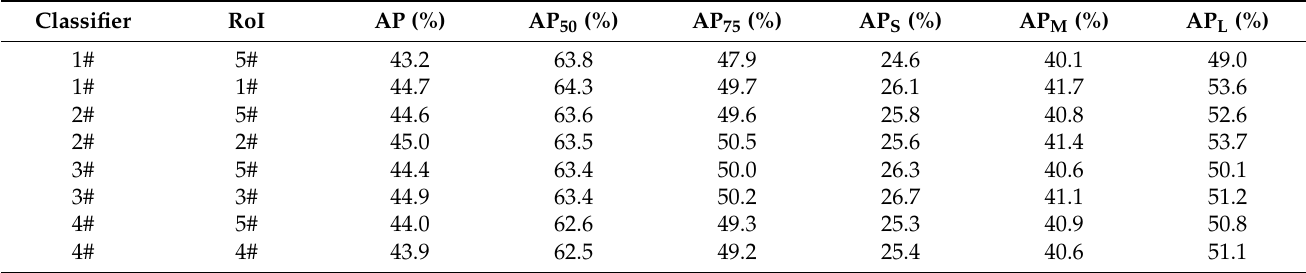
Table 1. Detection precision measured for different combinations of classifier and RoI vectors. 1#~5# denote the first~fifth stages,